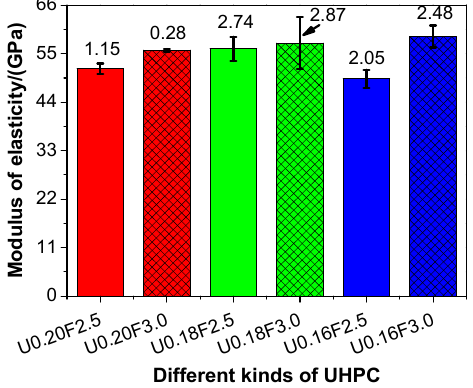
Figure 7. The Young’s modulus of different kinds of UHPC at 28 days.